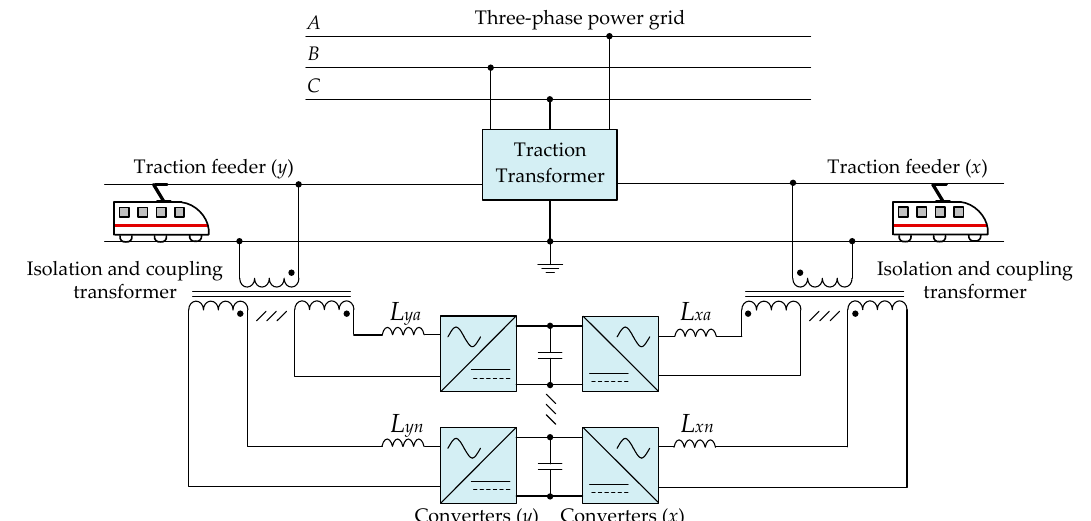
Table 8. Components quantities of the MRPC.